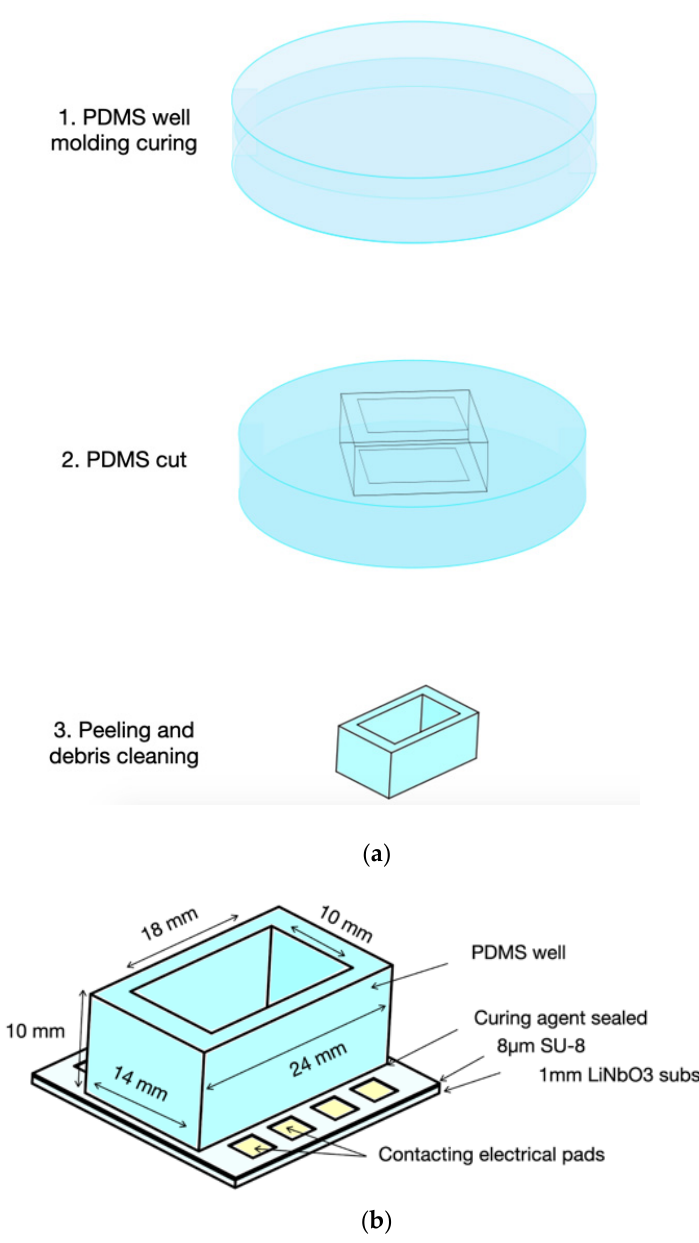
Figure 6. (a) Main fabrication steps for the PDMS fluidic chamber. ( b ) Schematic with dimensions of PDMS fluidic well glued to the Love wave sensor SU-8 guiding layer.